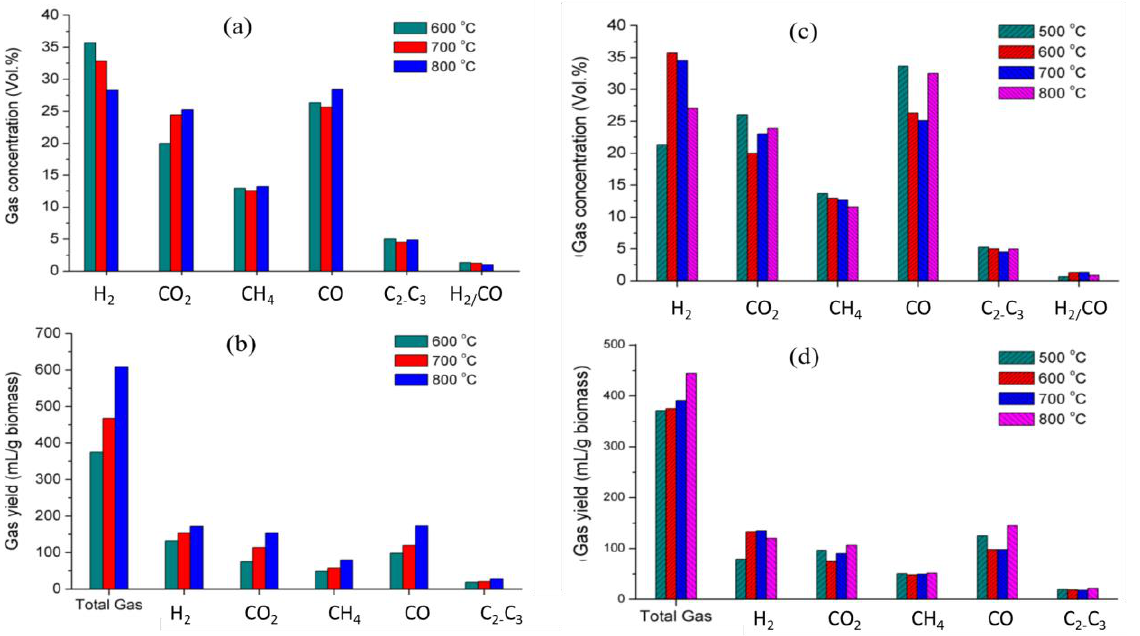
Figure 6. Bar diagram of ( a ) gaseous concentration, ( b ) gaseous yield of the syngas conversion of biomass pyrolysis, effect of catalytic bed temperature on ( c ) concentration, and ( d ) yield of the syngas. Reprinted from [49]. Copyright (2017), with permission from Elsevier.